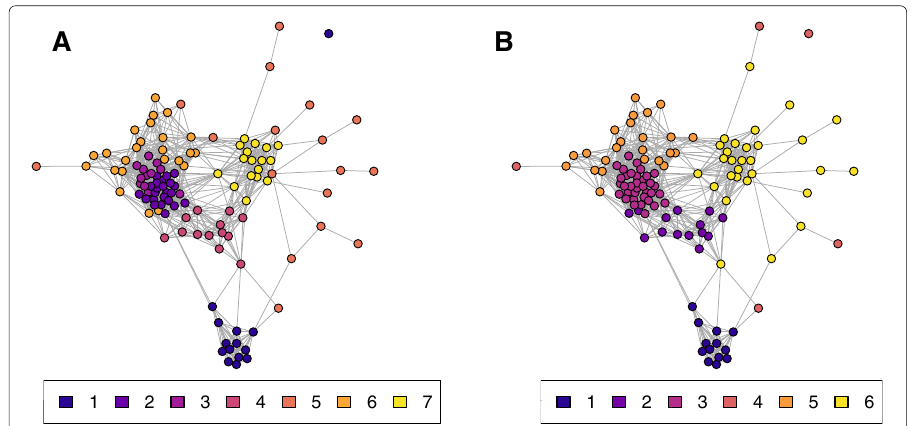
Fig. 8 Microbiome subject similarity network: A visualization of the 121 node microbiome subject similarity network with nodes colored by the partition using the classic ( a .) and attributed ( b .) stochastic block model. a . Fitting the classic stochastic block model to the network, 7 communities were identified. b . Fitting the attributed stochastic block model to the network with the attributes being the first 5 principle components of each subject’s OTU count vector (metagenomic profile), 6 communities were identified. Incorporating attributes in inferring this partition removed some of the noise in the partition on the network, specifically